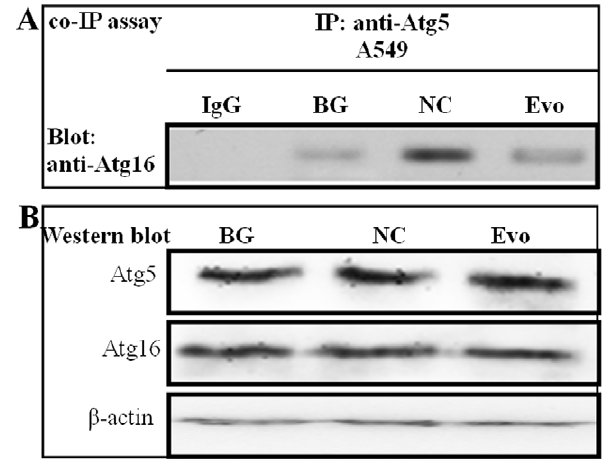
Figure 2. Evodiamine inhibits the interaction of Atg5-Atg12 and Atg16 determined by the Co-immunoprecipitation assay. ( A ) A549 cells in all groups were cotransfected with the pMC-atg5, pMN-atg12 and pEGFP-atg16 plasmids. A549 cell lysate was subjected to immunoprecipitation with an anti-Atg5 antibody, and the precipi- tates were subjected to Western blotting analysis using anti-Atg16 antibody. Normal rabbit IgG was used as a control. In the blank group (BG), the cells were not infected and not treated with drugs; in the negative control (NC) and Evo-treatment groups (Evo), the cells were infected (MOI=0.001) and treated without and with evodiamine (12.5 m g/mL) for 24 h, respectively. ( B ) The levels of Atg5, Atg16 and b -actin of the whole cell lysate were determined by Western